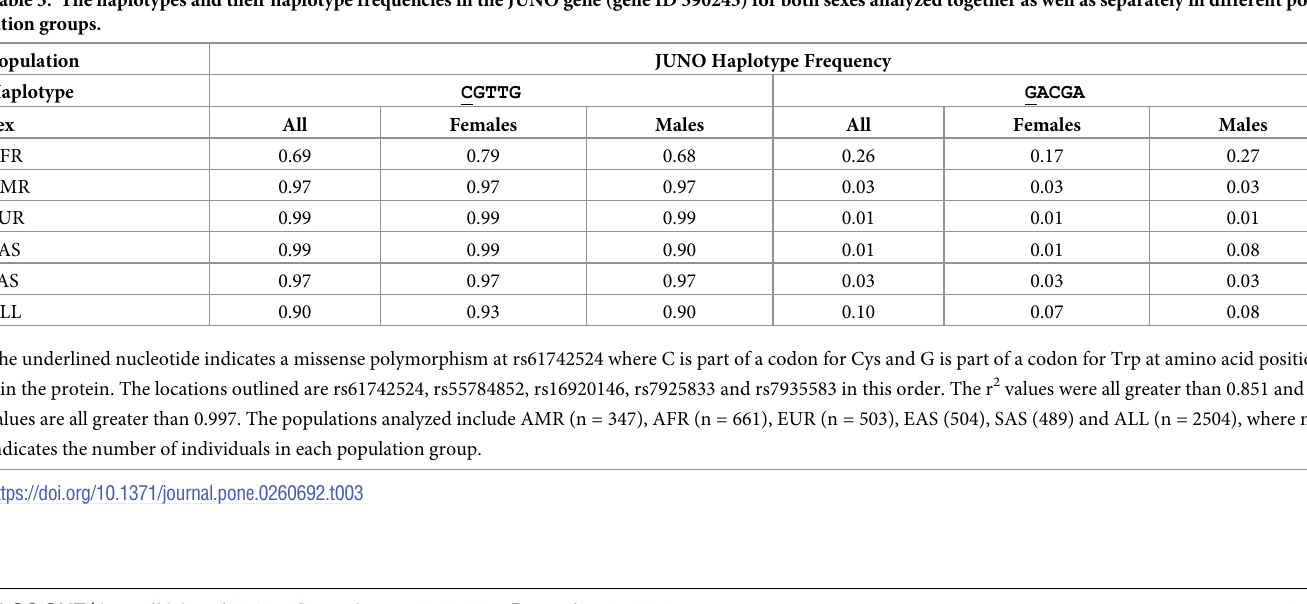
The haplotypes reported all contain missense mutations, which are underlined in the haplo- types in Tables 2 and 3. The missense mutation in the IZUMO1 sequence is a conserved substi- tution (Ala to Val), not expected to dramatically impact protein structure and function. For JUNO, the 2 amino acids substituted in the missense mutation are characteristically different: Trp is an aromatic amino acid with a hydrophobic character, whereas Cys has a polar neutral side chain. This amino acid substitution could affect protein function.